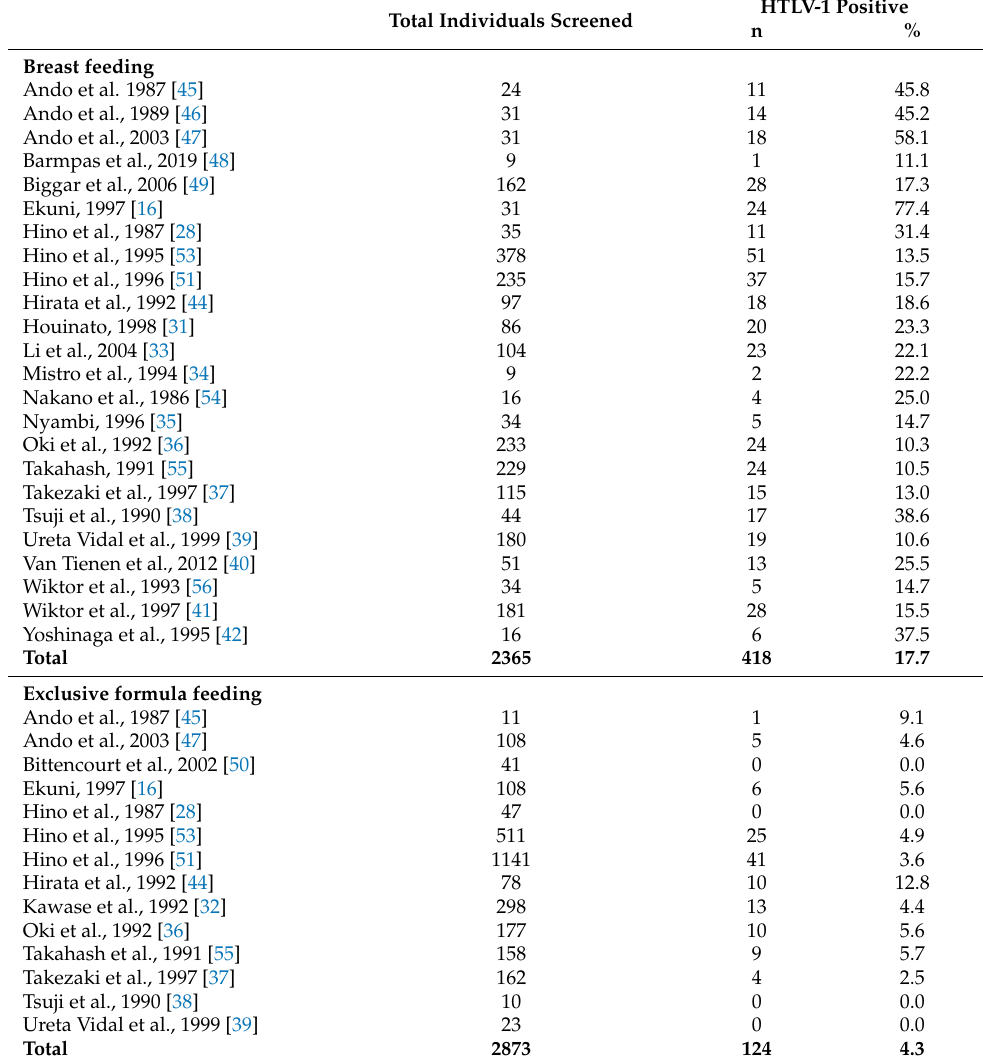
Total Individuals Screened